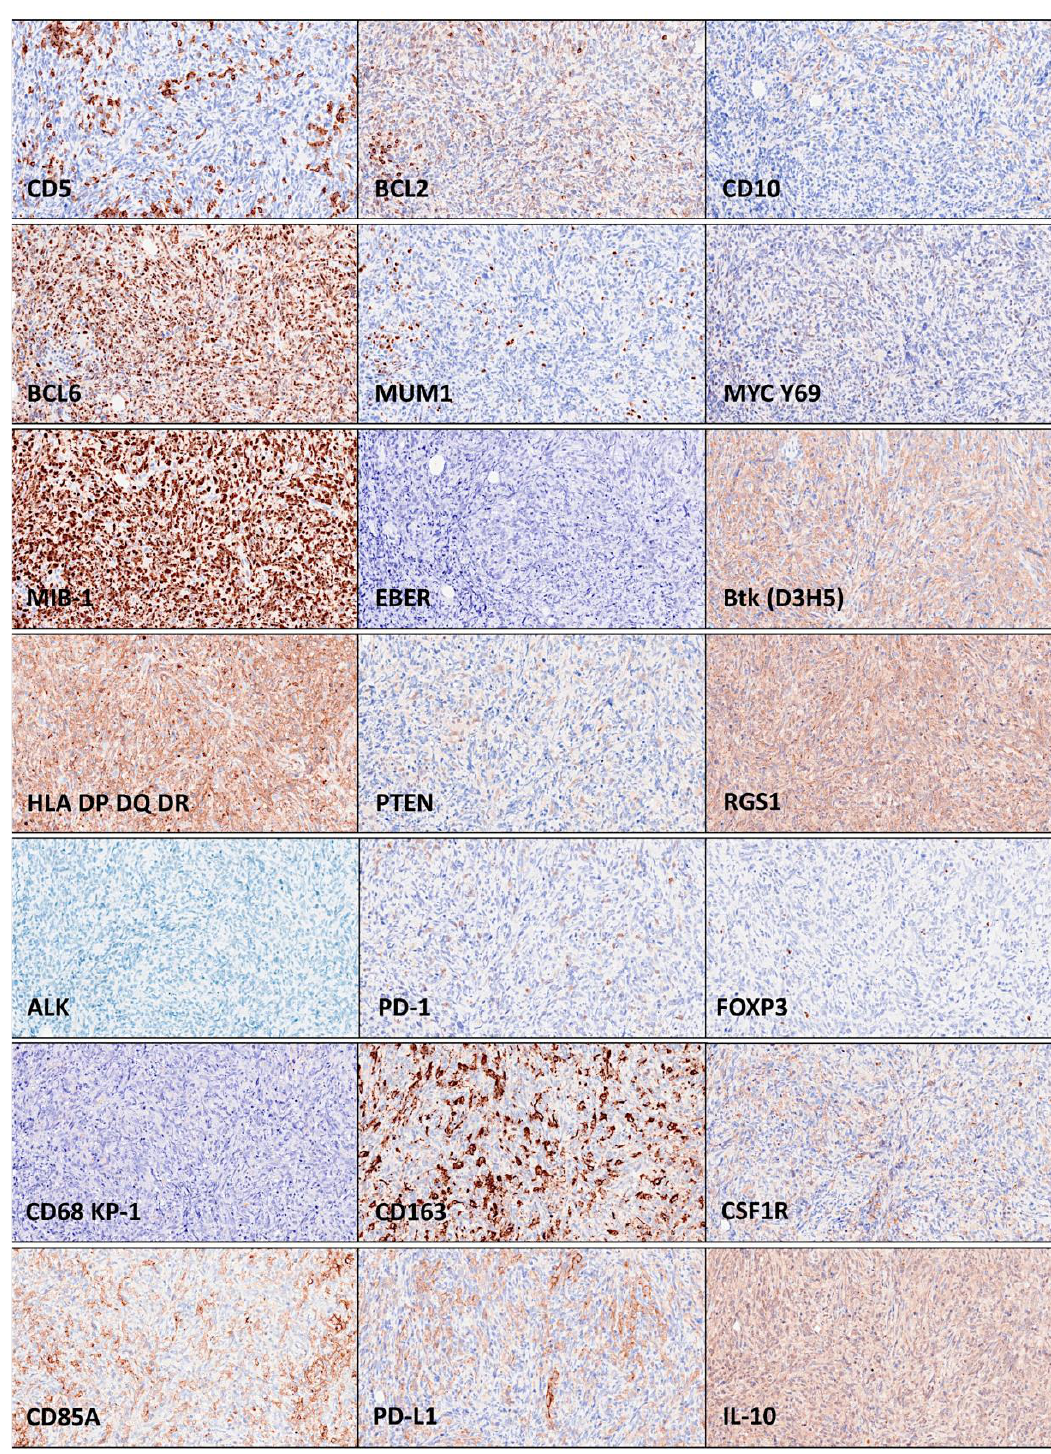
Figure 2. Histological features of the right supraclavicular (lymph) node enlargement (continuation). The neoplasia was BCL2-, BCL6-, MYC-, MIB-1-, BTK-, HLA-DP-DR-, RGS1-, and IL-10-positive. Being CD10-negative, BCL6-positive, and MUM1-negative, the spindle cell variant diffuse large B-cell lymphoma had a cell-of-origin of the germinal center B-cell (GCB) type. The immune microen- vironment was characterized by moderate PD-1-positive cells, low FOXP3 Tregs, and moder- ate/high infiltration of tumor-associated macrophages (TAMs) with M2-like polarization as CD163, CSF1R, CD85A (LILRB3), and PD-L1 positivity.